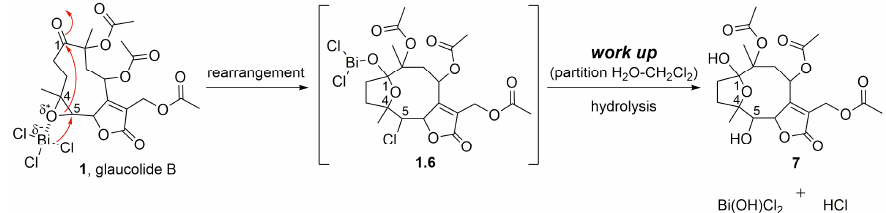
Figure 5. Proposed mechanism for the formation of SL semisynthetic derivative 7 (red arrows illustrate the arrow-pushing mechanism).